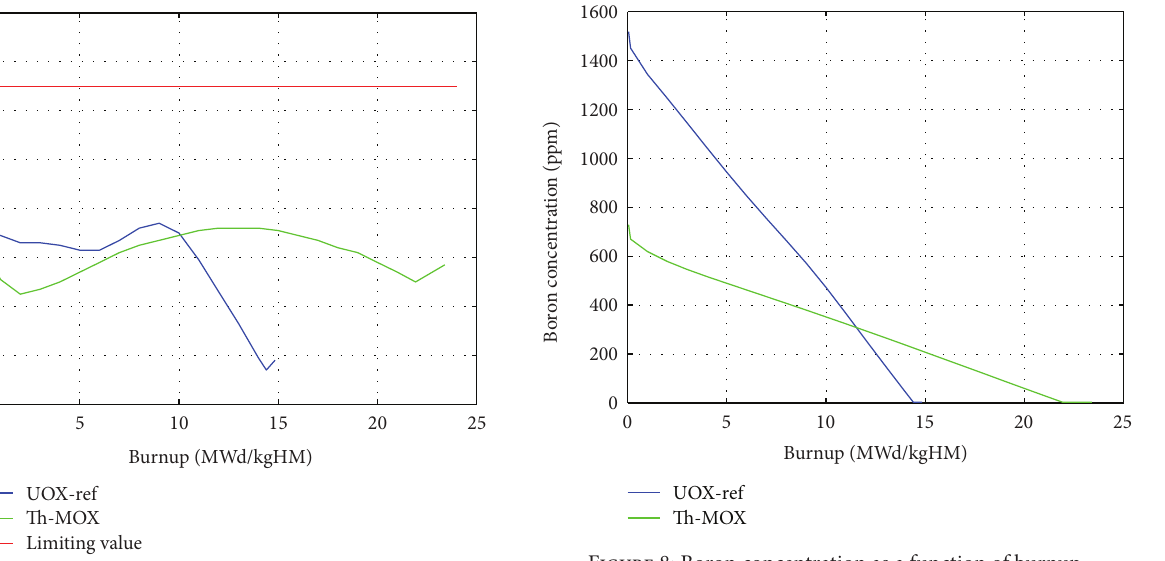
Figure 7: 𝐹 Δ𝐻 , that is, maximum rod power relative to core average rod power as a function of burnup.